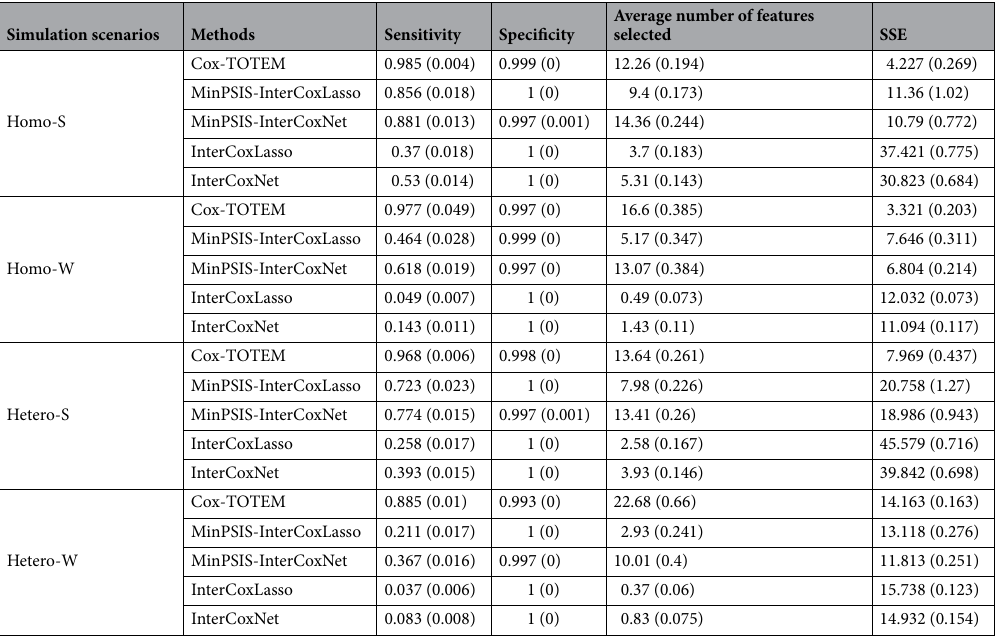
Table 1. Comparison of variable selection and parameter estimation under the four different scenarios with n = 100 , p = 2000 and s = 10 true predictors. Mean results of 100 replications are reported with standard errors shown in the